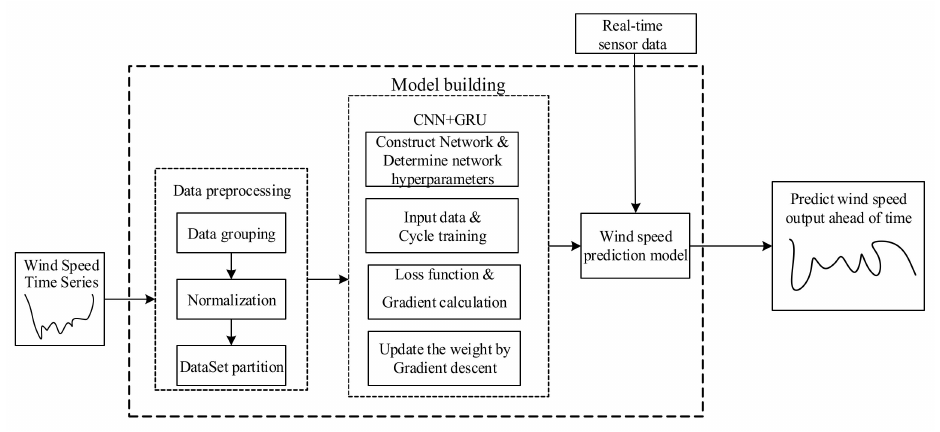
Figure 1. The framework of the wind speed prediction